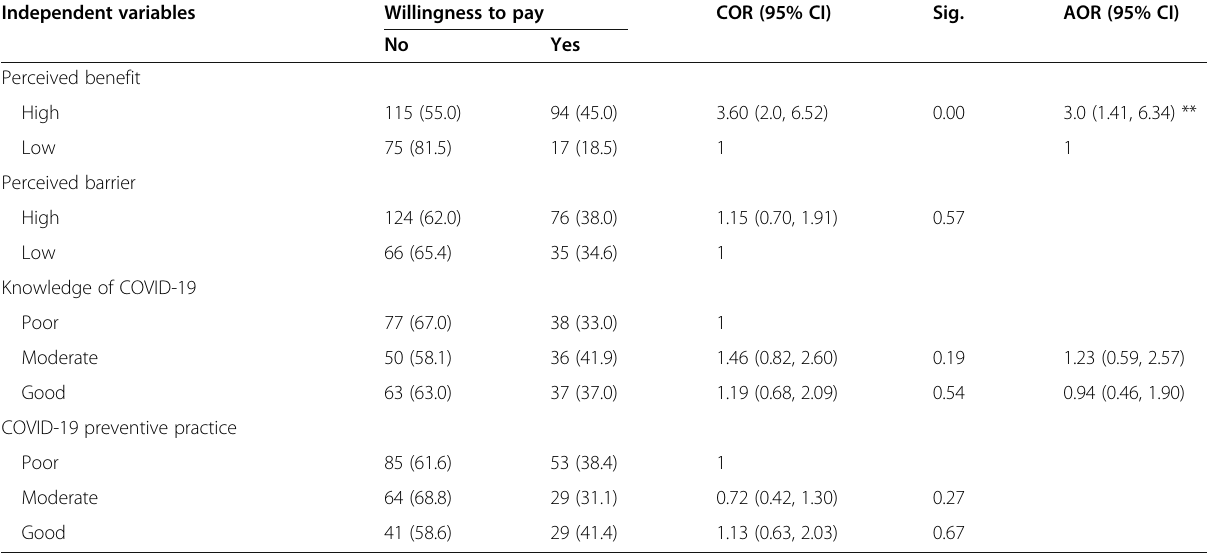
Table 3 Factors associated with willingness to pay for COVID-19 vaccine among school teachers in Gondar City, Northwest, Ethiopia (n = 301)